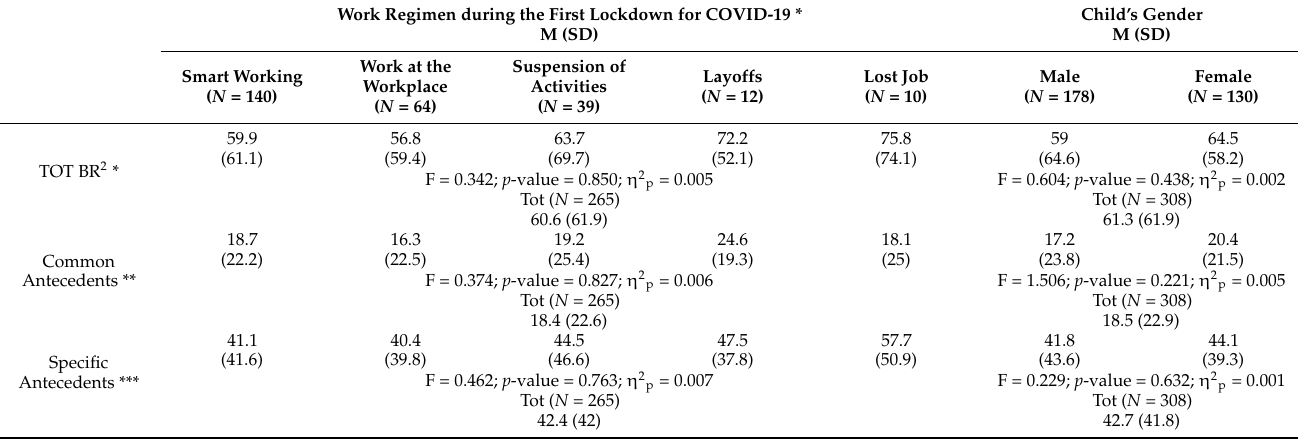
Table 6. Parental distress descriptive data and ANOVA analyses for work regimen during the first lockdown and child gender. Work Regimen during the First Lockdown for COVID-19 * M